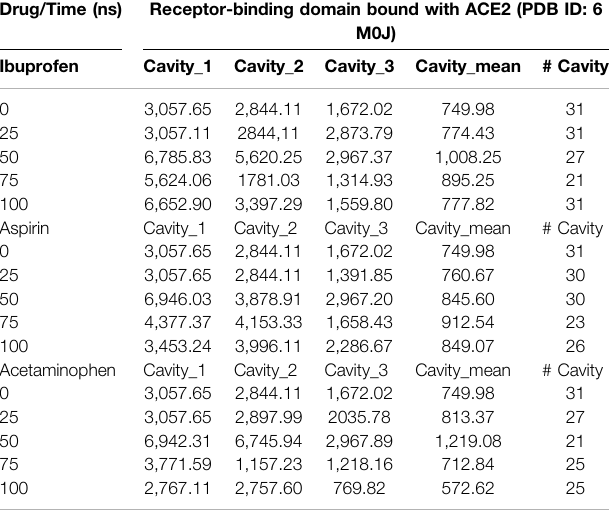
TABLE 9 | Prediction of potential allosteric sites in the ligand binding pockets at TABLE 8 | Distribution ofmain cavities oftheRBD-ACE2complex inthepresence the interface of the RBD-ACE2 complex as a function of simulation time. of NSAIDs and as a function of the simulation time. Drug/Time (ns) Receptor-binding domain bound with Drug/Time (ns) Receptor-binding domain bound with ACE2 (PDB ID: 6 ACE2 (PDB ID: 6 M0J) M0J)